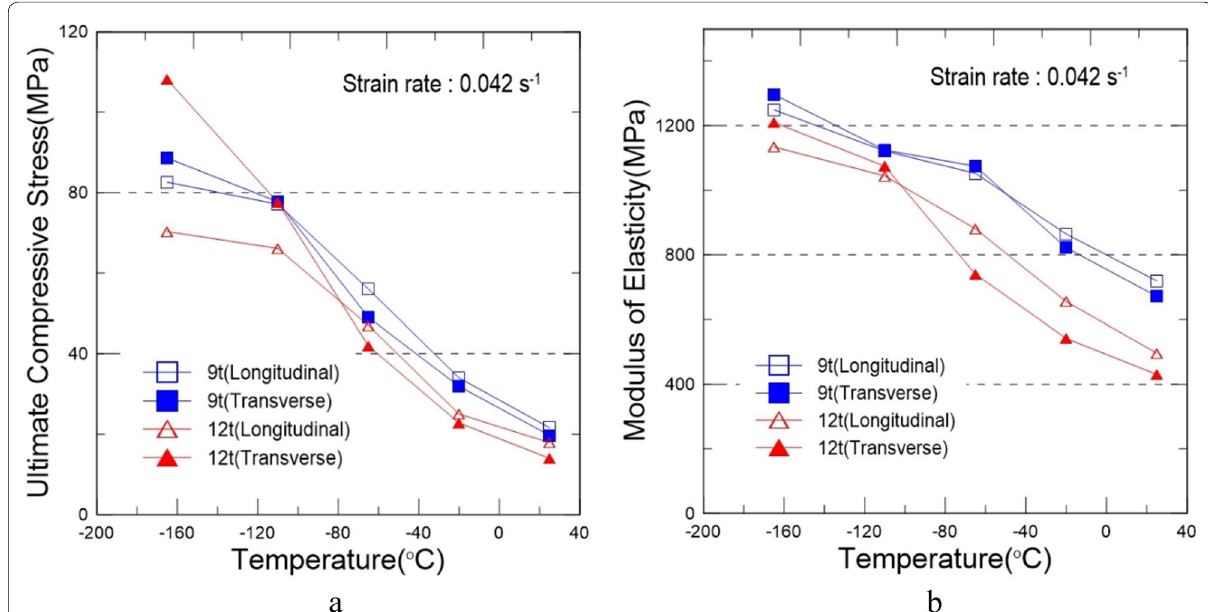
Fig. 10 a – d Average modulus of elasticity of plywood in longitudinal and transverse fiber directions